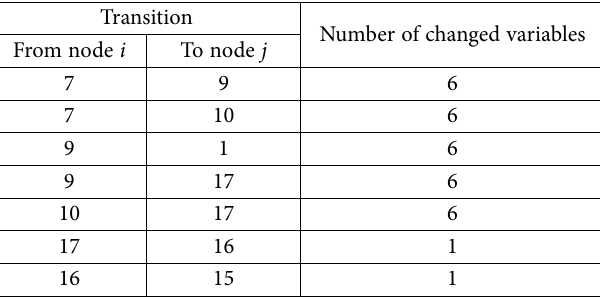
Table 8. Changes of variables (source: elaborated by the authors)